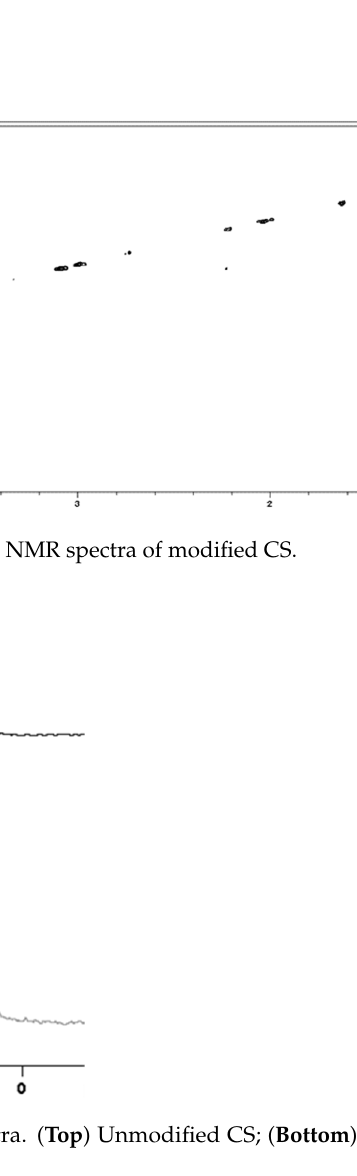
Figure 3. 1 H solution state NMR spectra. (Bottom) Unmodified CS. (Top) Modified CS.